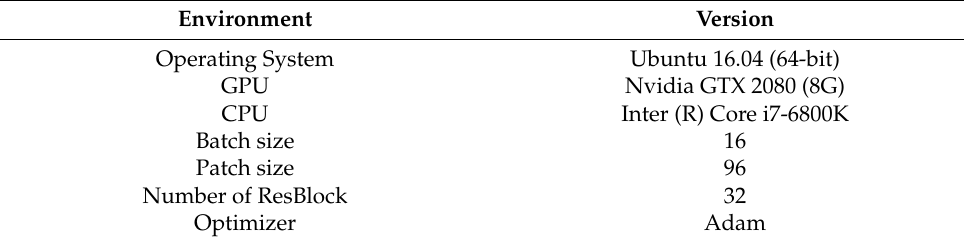
Table 1. Experimental environmental